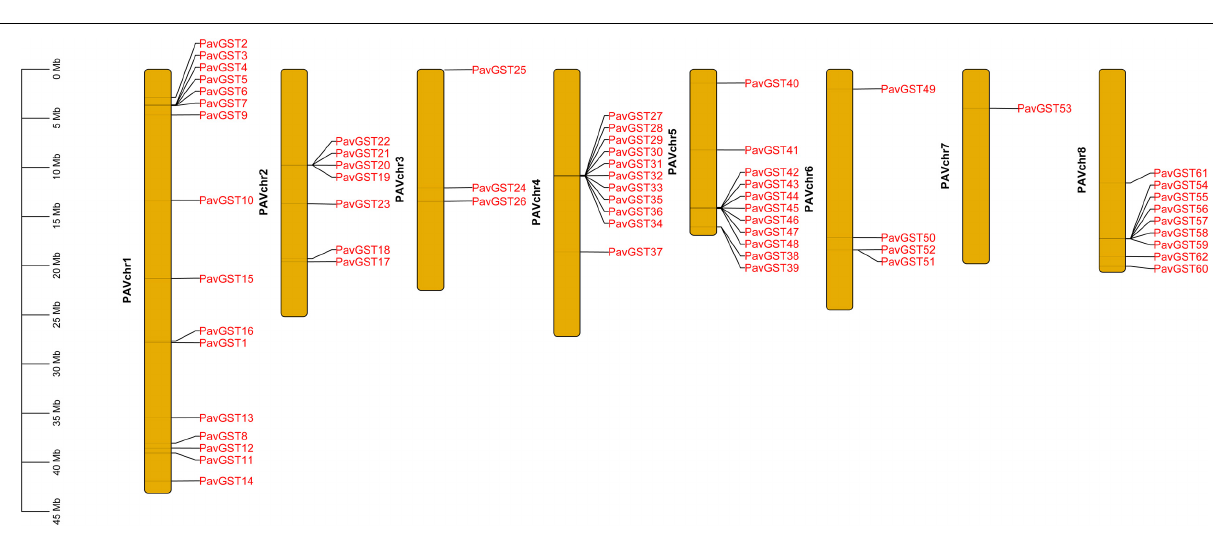
FIGURE 7 | Chromosome localization of PavGST genes on 8 chromosomes and scale represents the length of each